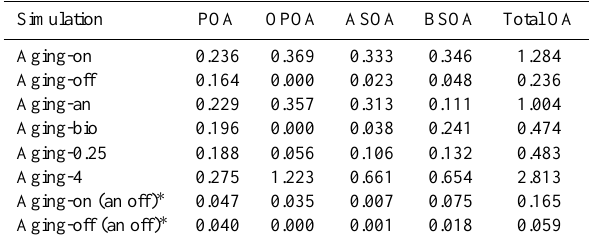
Table 6. Period-averaged organic aerosol mass concentration (µgm − 3 ) in the boundary layer ( ∼ 1km) over the outer domain. Simulation POA OPOA ASOA BSOA Total OA Aging-on 0.236 0.369 0.333